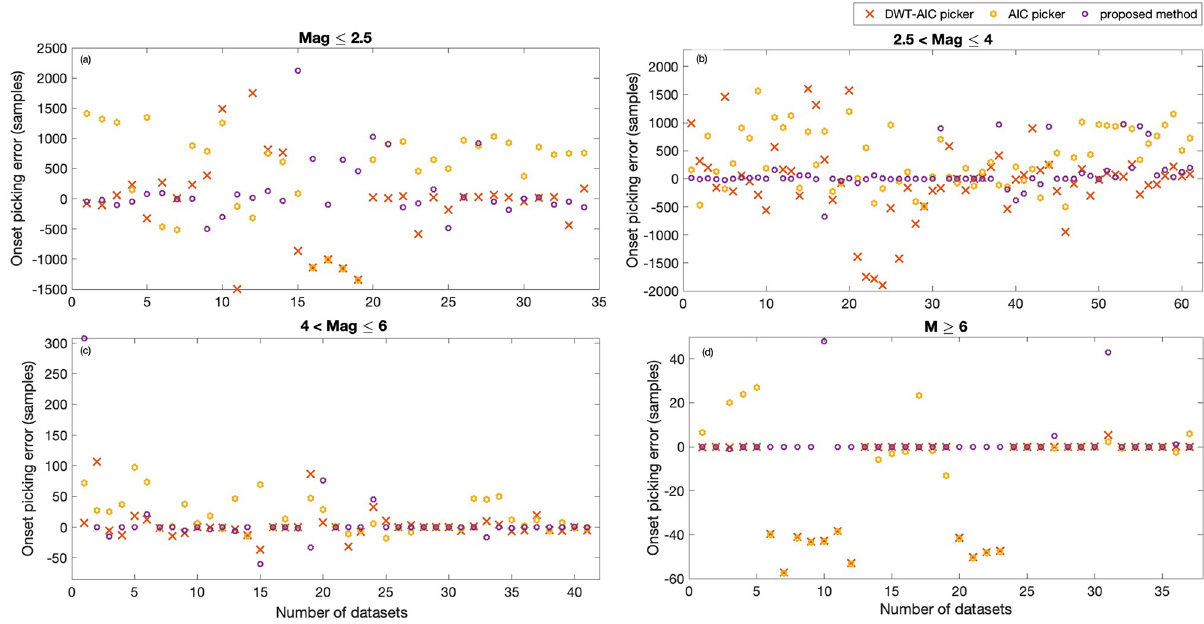
Fig 14. Comparison with existing pickers. Picking error in samples is reported for all the four categories, (a) Mag � 2.5, (b) 2.5 < Mag � 4, (c) 4 < Mag � 6 and (d) Mag > 6.